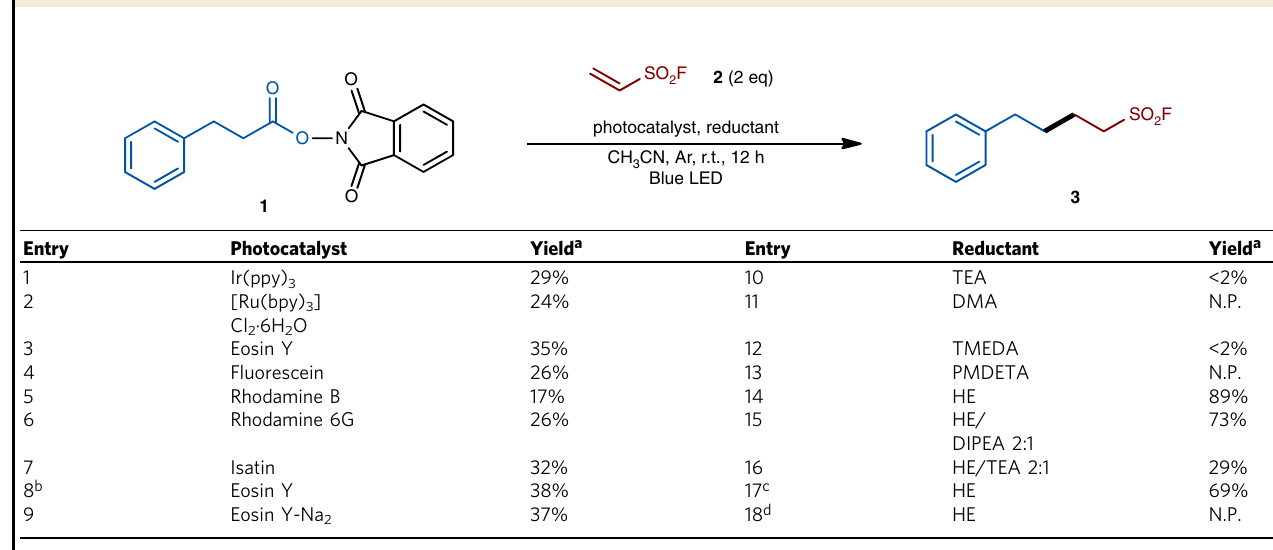
Table 1 Reaction optimization (Reaction conditions: 0.05 mmol scale, VSF (2 eq), photocatalyst (5 mol%), in MeCN (0.5 mL) at room temperature, under the irradiation of 18 W × 2 blue LED bulbs. Left entries: with DIPEA (2 eq) as the reductant. Right entries: with Eosin Y-Na 2 (5 mol%) as the catalyst)